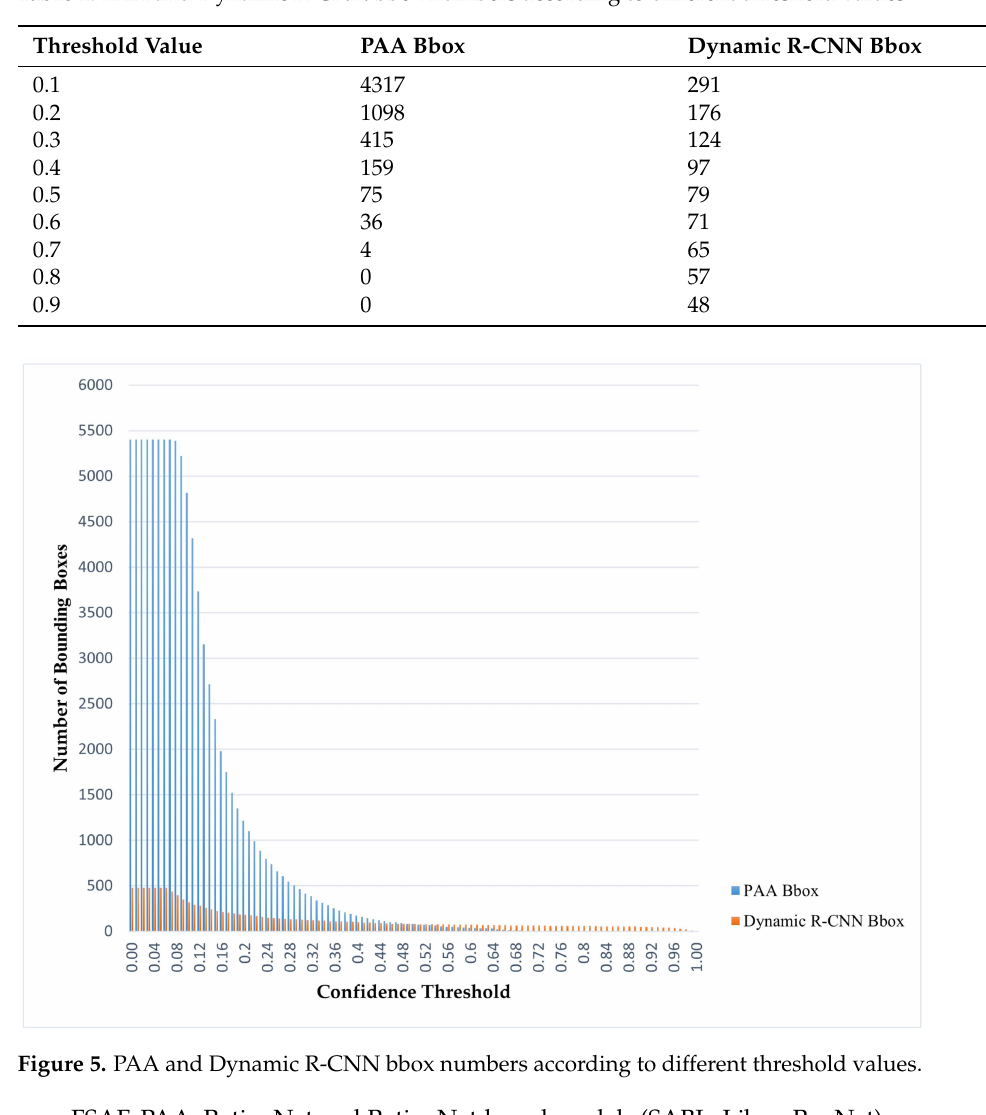
Table 1. PAA and Dynamic R-CNN bbox numbers according to different threshold values.